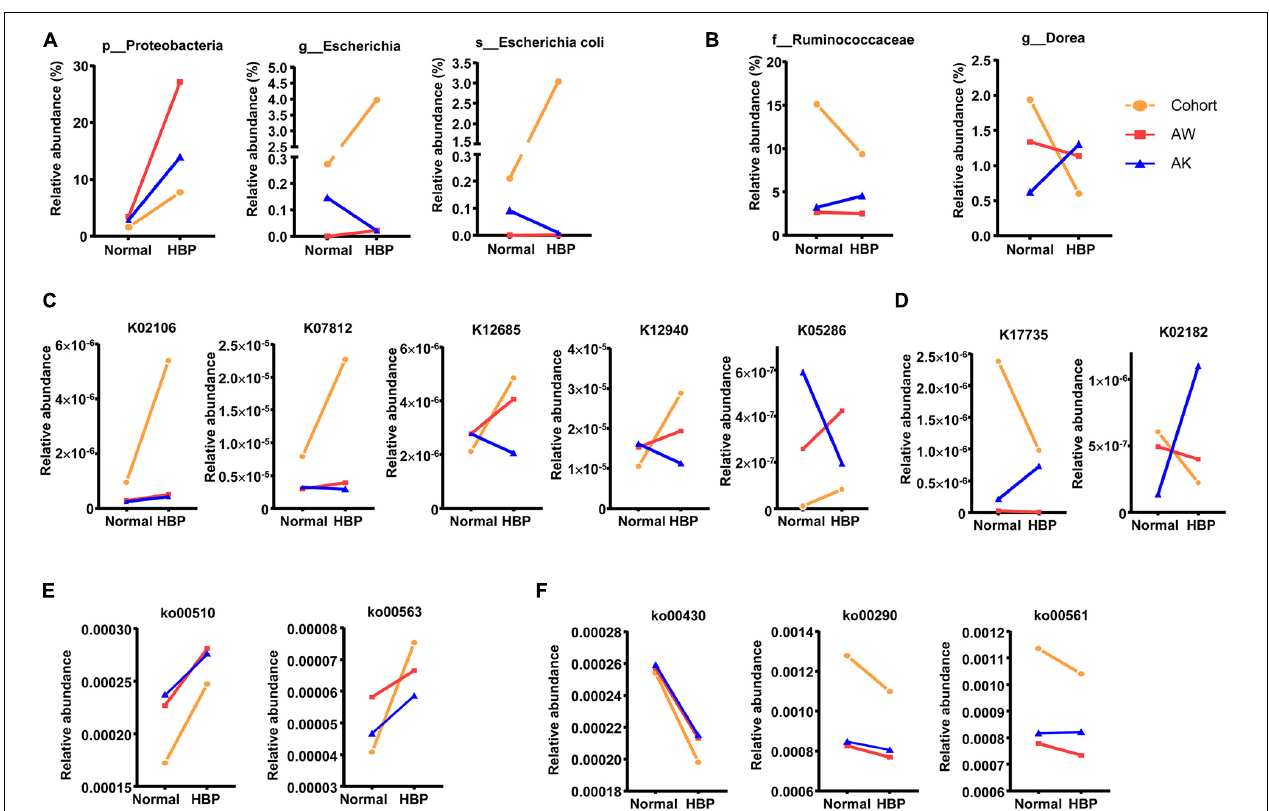
FIGURE 5 | Significantly different gut microbiome components between healthy control and primary hypertension patients that are potentially affected by macrophage–adenosine monophosphate-activated protein kinase (AMPK) mechanism. (A) Significantly different bacterial strains that are potentially promoted after macrophage-AMPK activation, and their relative abundant changes from normal blood pressure groups to hypertension groups. (B) Significantly different bacterial strains that are potentially inhibited after macrophage-AMPK activation, and their relative abundant changes from normal blood pressure to hypertension condition. (C) Significantly different orthologs that are potentially promoted after macrophage-AMPK activation, and their relative abundant changes from normal blood pressure to hypertension condition. (D) Significantly different orthologs that are potentially inhibited after macrophage-AMPK activation, and their relative abundant changes from normal blood pressure groups to hypertension groups. (E) Significantly different pathways that are potentially promoted after macrophage-AMPK activation, and their relative abundant changes from normal blood pressure to hypertension condition. (F) Significantly different pathways that are potentially inhibited after macrophage-AMPK activation, and their relative abundant changes from normal blood pressure groups to hypertension groups. In each graph, the orange line shows change trend from healthy control group (Normal) to primary hypertension patient group with antihypertension medications (HBP), the red line shows change trend in wild-type mice from basal level (Normal) to AngII-induced hypertension level (HBP), and the blue line shows change trend in AMPK-knockout mice from basal level (Normal) to AngII-induced hypertension level (HBP). The meanings of AW and AK are the same as in Figure 4 .